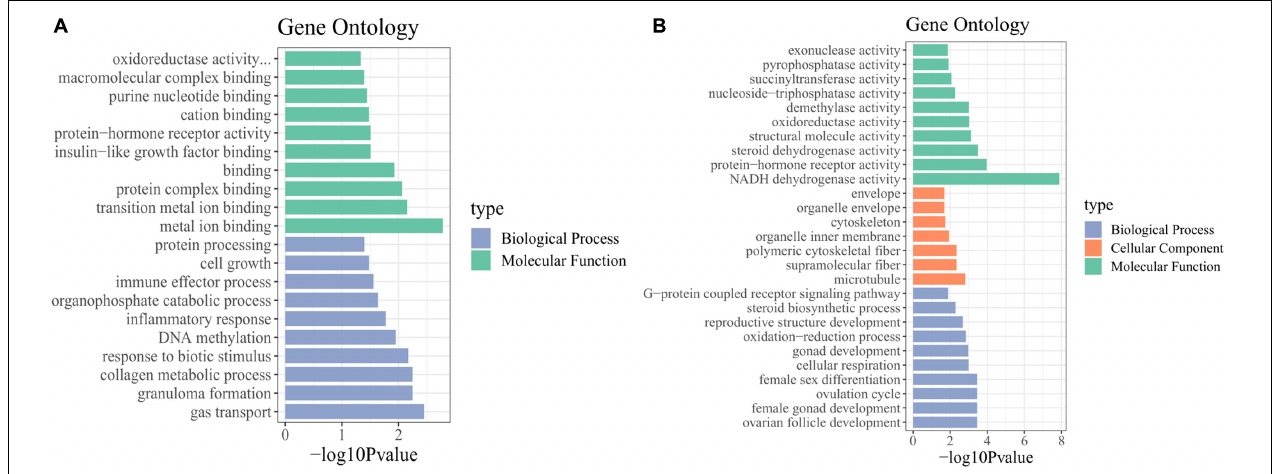
FIGURE 3 | GO enrichment analysis of DE mRNAs. GO terms enriched in (A) stage IV vs. V. and (B) stage V vs. VI.